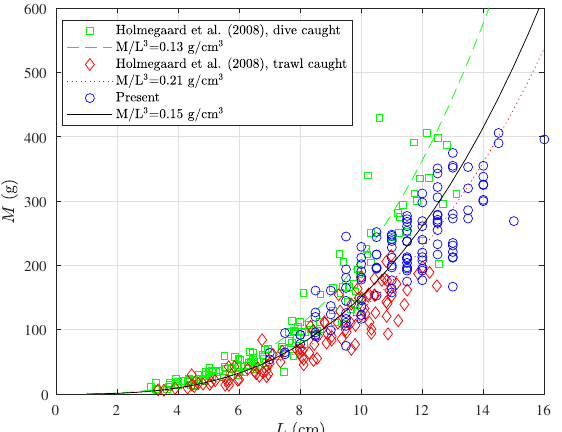
Figure 10. Measured mass of Asterias rubens . The solid black line corresponds to (16). Other data are from